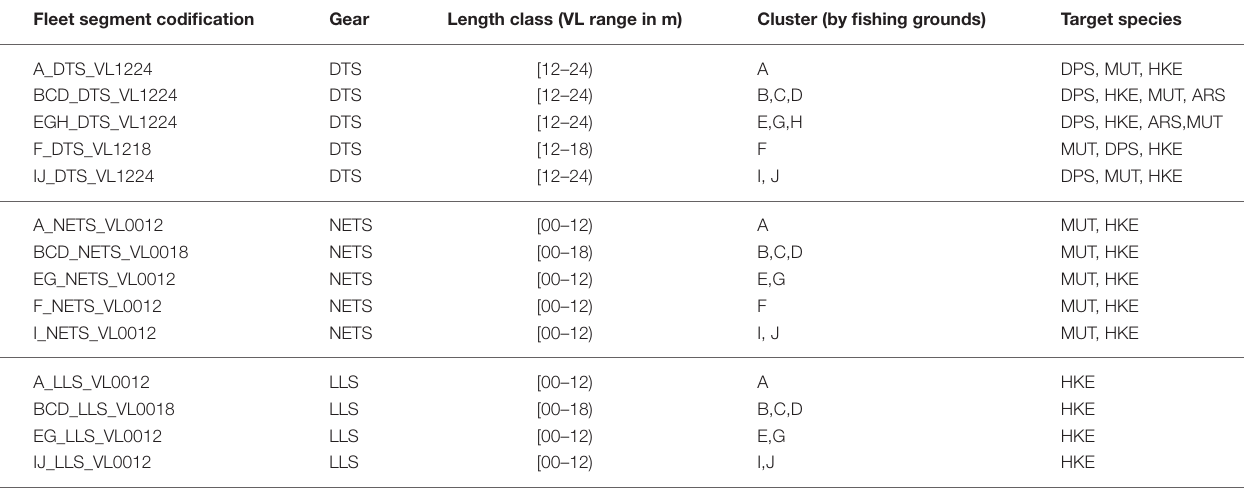
TABLE 1 | Fleet segment definition with respect to the gear (DTS stands for bottom otter trawl, NETS stands for gill net and trammel nets, LLS stands for longliners), the fishing grounds of activities, and the target species: M. merluccius , M. barbatus , P. longirostris , A. antennatus . Fleet segment